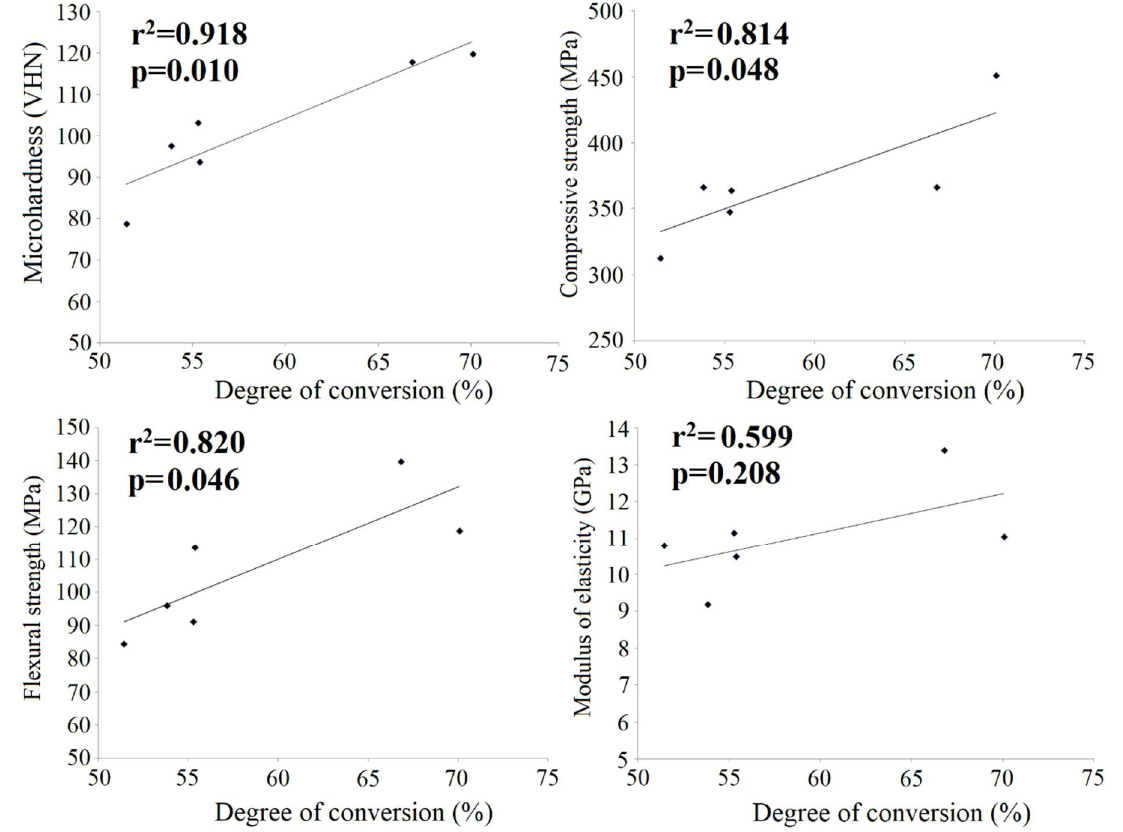
Figure 5. Correlation between mechanical properties and the degree of conversion of core composites.